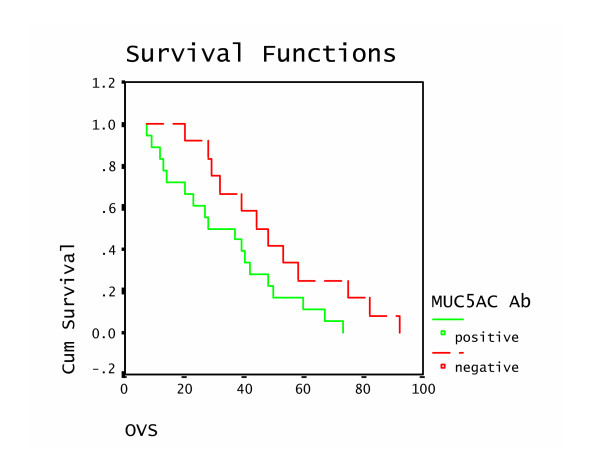
Survival curve of the colorectal tumor patients with MUC5AC antibody positive and MUC5AC antibody negative determined by the Kaplan Meier method. MUC5AC antibody positive patients showed significantly worse survival than those with MUC5AC antibody negative patients (p = 0.052). Cum Survival = Probability of cumulative survival. OVS = Overall survival.